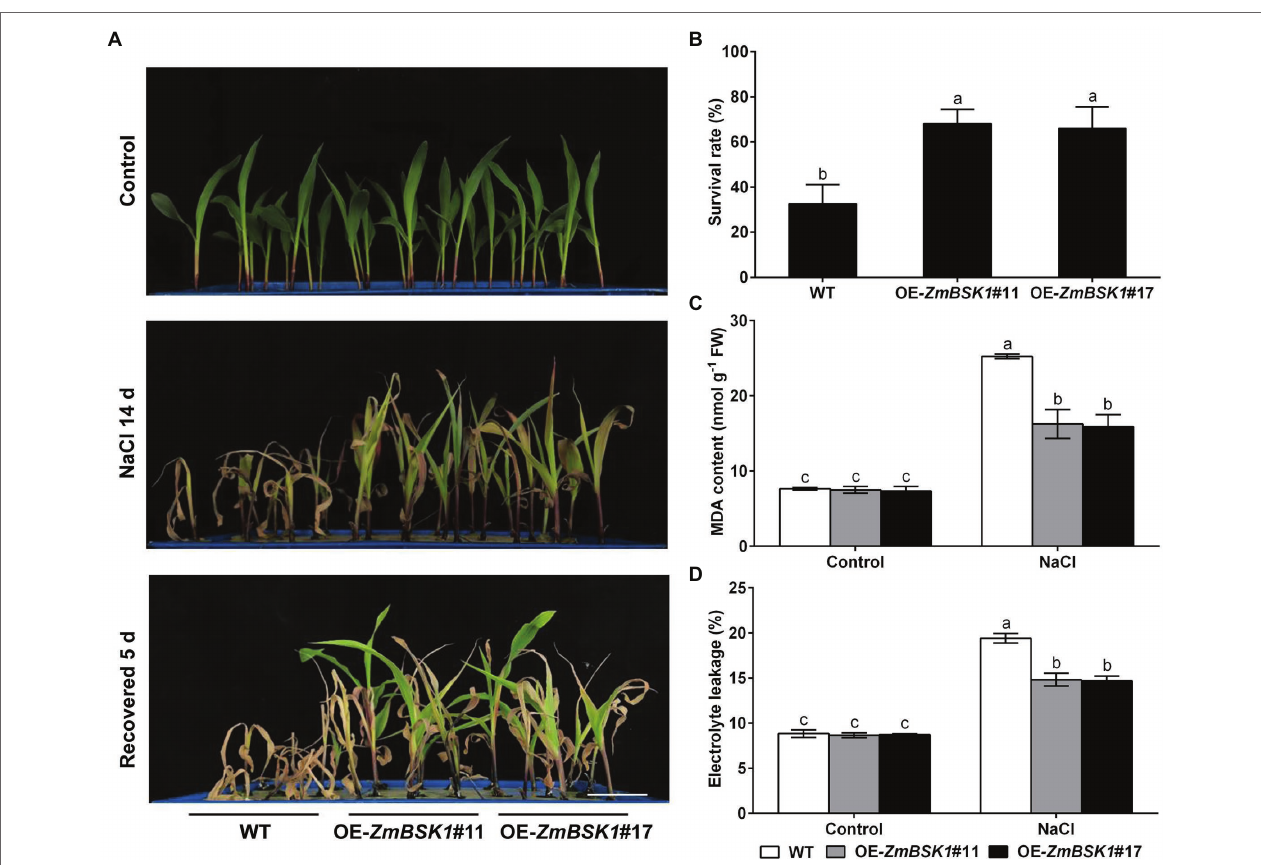
FIGURE 3 | Overexpression of ZmBSK1 improves salt tolerance in maize. (A) The phenotypes of OE- ZmBSK1 and WT maize plants under salt stress. About 10-day-old maize seedlings were treated with 200 mM NaCl for 14 days, and then recovered for 5 days. Scale bar = 5 cm. (B) Survival rate (%) of maize plants in (A) . At least 45 seedlings of each line per replicate were used for survival rate analysis. The malondialdehyde (MDA) content (C) and the percentage of electrolyte leakage (D) in leaves of OE- ZmBSK1 and WT maize plants under salt stress. About 10-day-old maize seedlings were treated with 200 mM NaCl for 2 days, and then the physiological indexes as indicated were measured. Error bars in (B–D) represent ±SD ( n = 3). Different letters indicate significant differences at p < 0.05 according to one-way or two-way ANOVA (Duncan’s multiple range